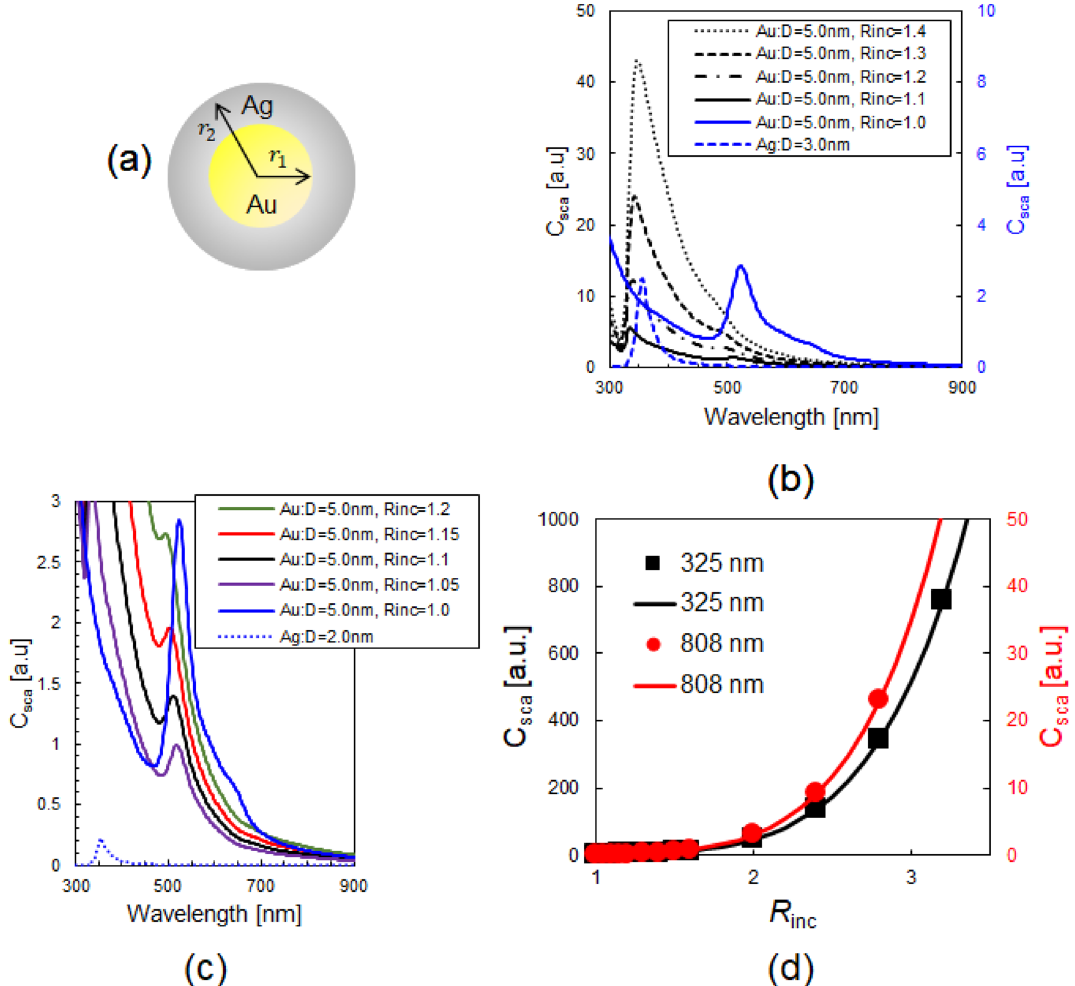
Figure 5. ( a ) Calculation model illustration of Ag coated Au NPs. r 1 : radius of Au core, r 2 : radius of core–shell structure. r 2 − r 1 : Ag thickness. ( b ) and ( c ) Calculated values of C sca for different R inc ( = r 2 / r 1 ) . Black curves in ( b ) correspond to the vertical axis on the left side and blue curves in ( b ) are associated with the vertical axis on the right side. ( c ) Detailed spectra with R inc < 1.2 . ( d ) C sca values obtained at 325 nm (black solid squares) b C sca = aR b and 808 nm (red solid circles). Fitting curves: C sca = aR inc for 325 nm (black solid curve) and inc for 808 nm (red solid curve).